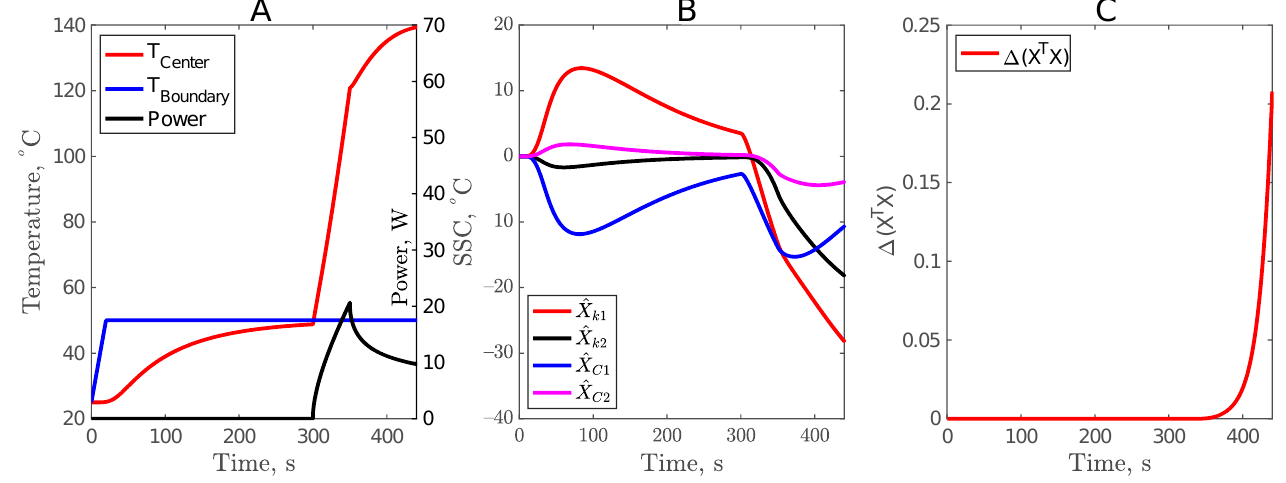
Figure 3. Center temperature profile with power input ( A ), scaled sensitivity coefficients ( B ), and criteria for optimal design ( C ) for the CD2 experimental design.